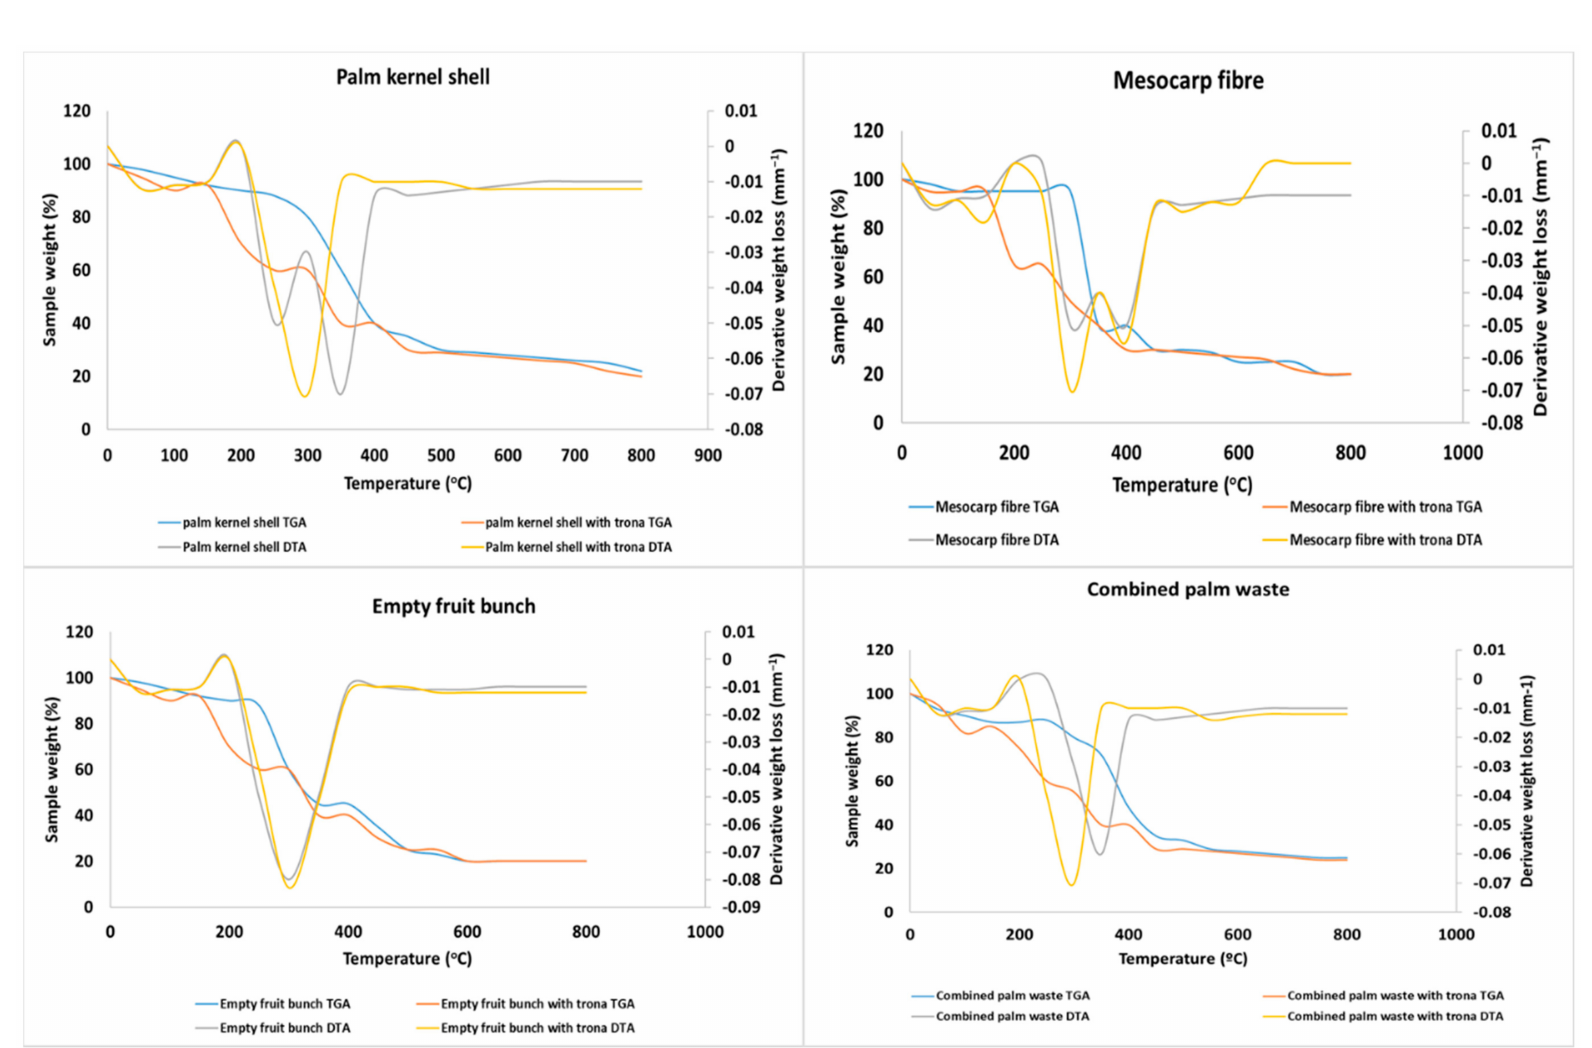
Figure 1. DTA / TGA of OPW and variation of the samples impregnated with trona